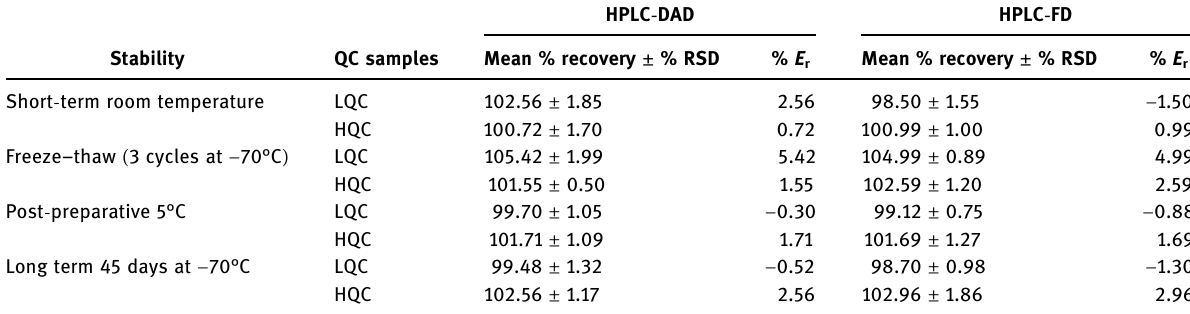
Table 4: Stability tests of RM in human plasma ( n = 6